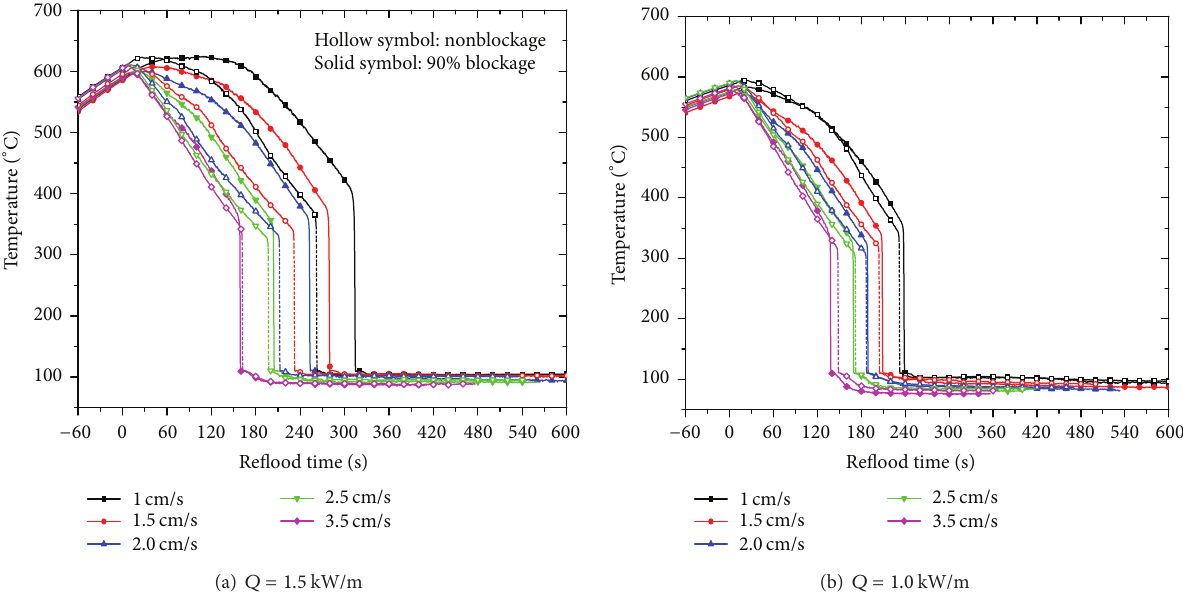
Figure 5: Comparison of the temperature profiles at the upstream region (600mm).